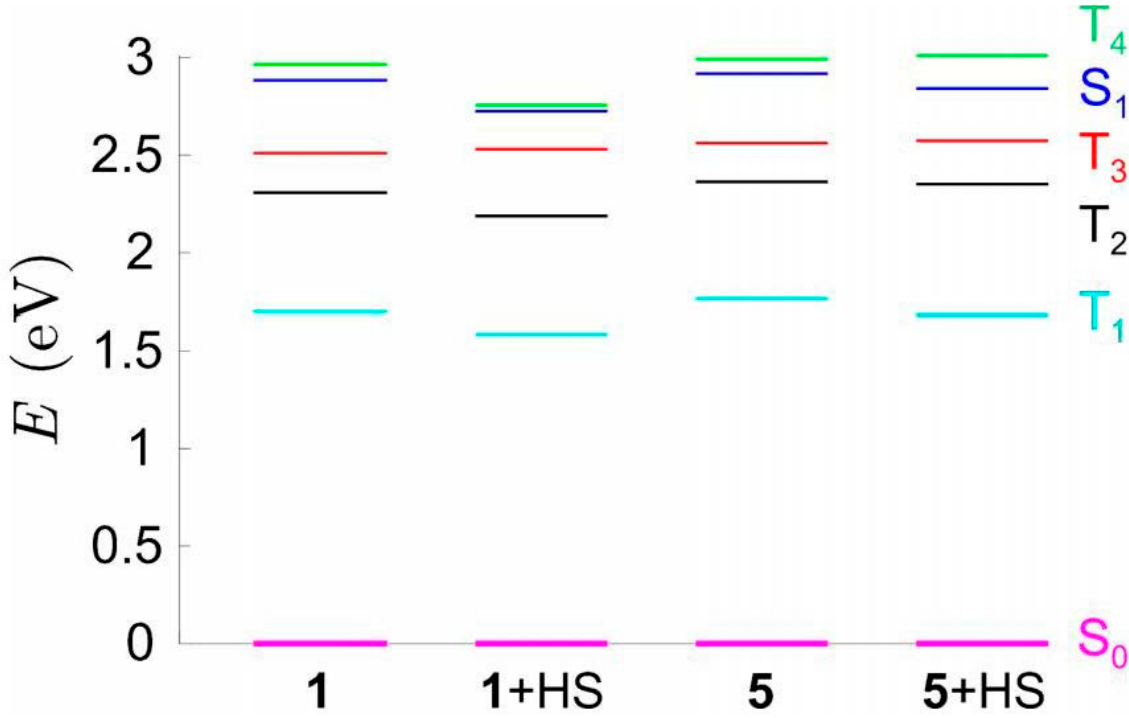
Table 1. Computed vertical and adiabatic excitation energies (eV) and oscillator strength for the S 1 ← S 0 transitions.